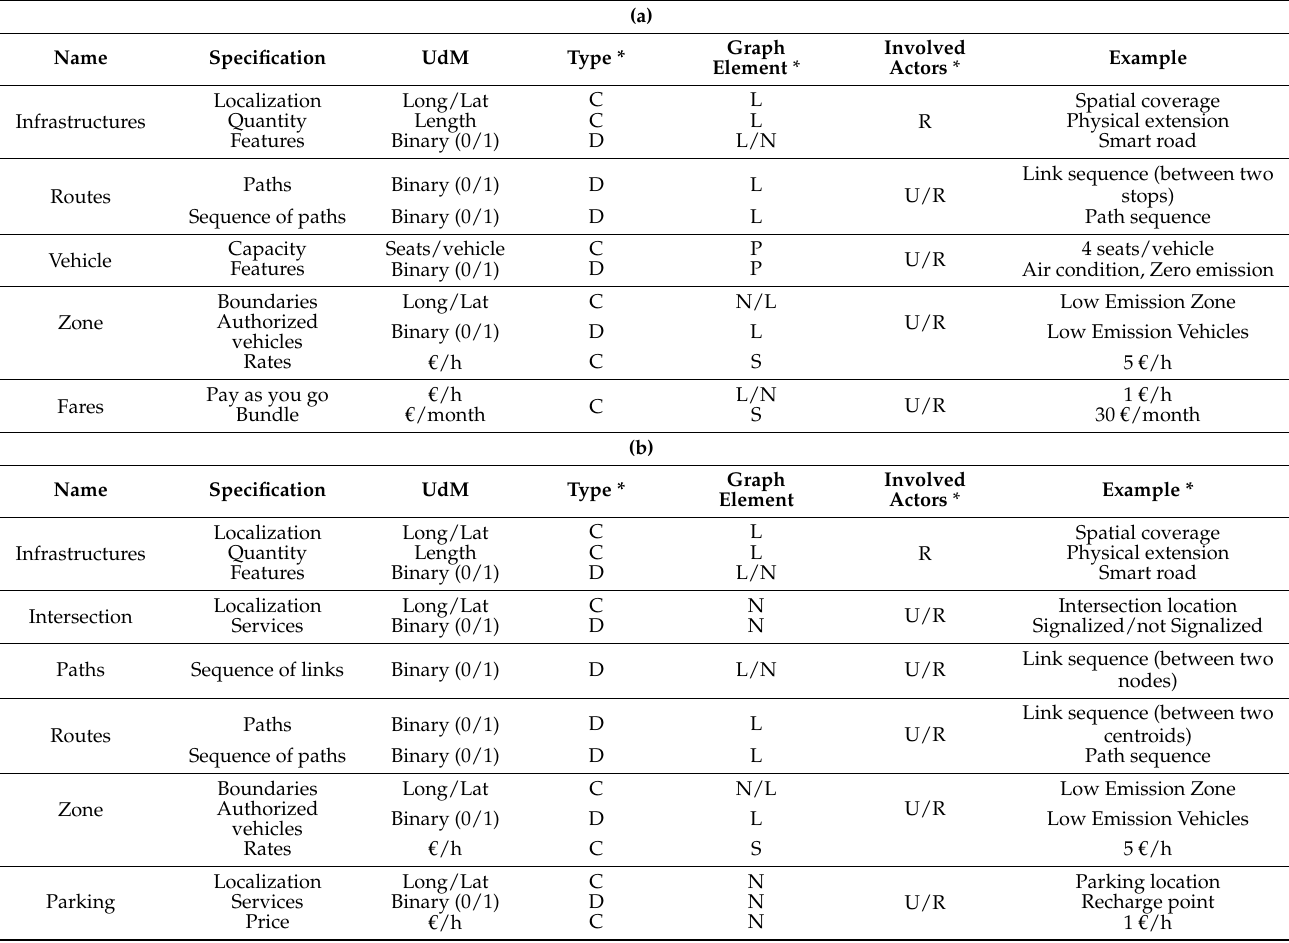
Table 4. ( a ) Main control variables: individual services as passenger. ( b ) Main control variables: individual services as